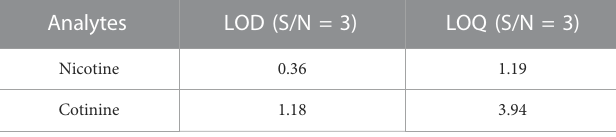
TABLE 1 LODs and LOQs of nicotine and cotinine.